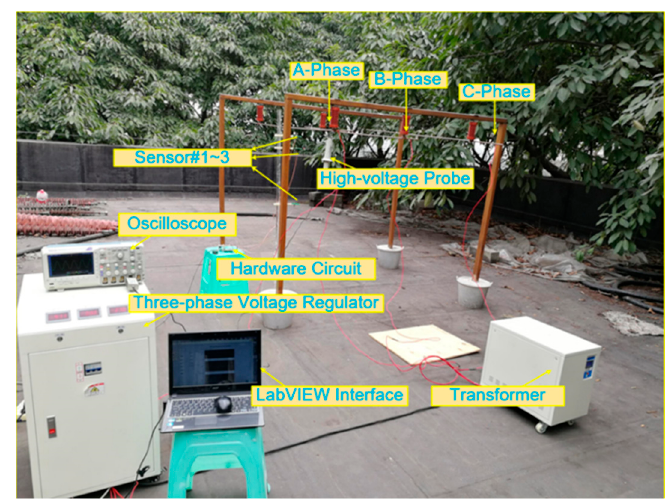
Figure 10. Three-phase overhead line voltage measurement test platform.